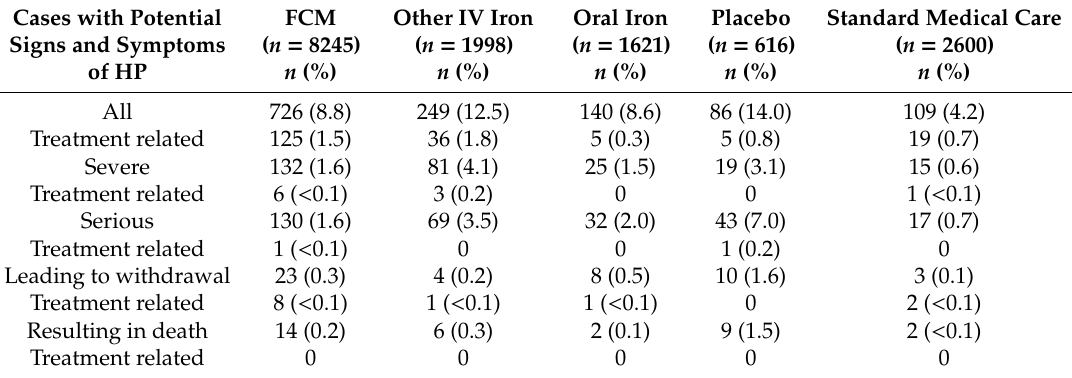
Table4. Ratesofadverseeventsclassifiedaspotentialclinicalsignsofhypophosphataemia. AEspossibly related to HP were identified by cross-checking against a set of 318 MedDRA Preferred Terms (including, but not limited to, fatigue, muscle weakness, muscle pain, bone pain, osteomalacia, haemolysis, white cell dysfunction, neurological symptoms, cardiac failure, and ventricular